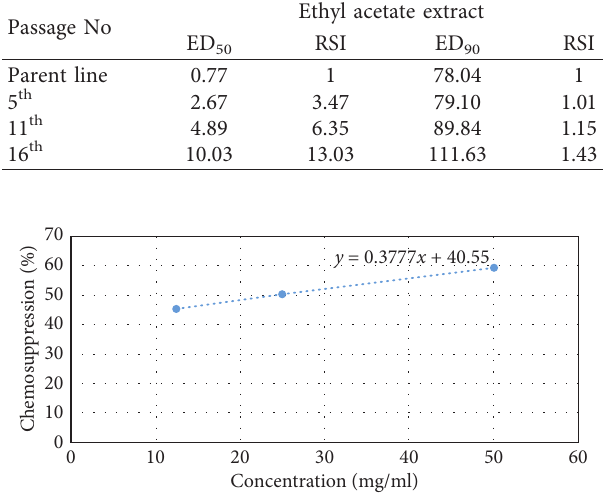
Figure 1: ED 50 and ED 90 at passage 16 (methanolic extract against P. berghei ANKA).